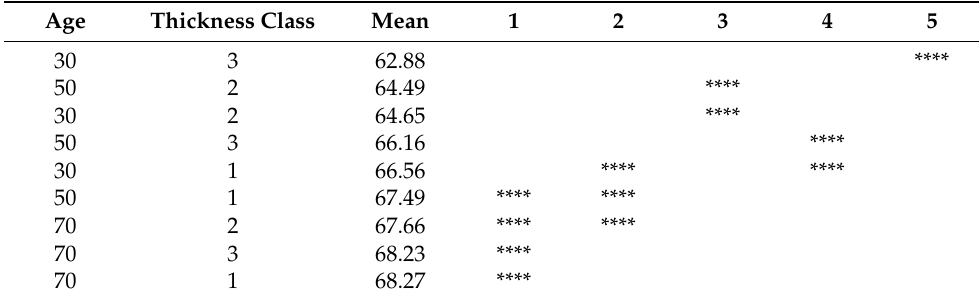
Table 4. Homogeneous groups in terms of mean wood hardness values for tree age and thickness class (HSD Tukey’s range test).